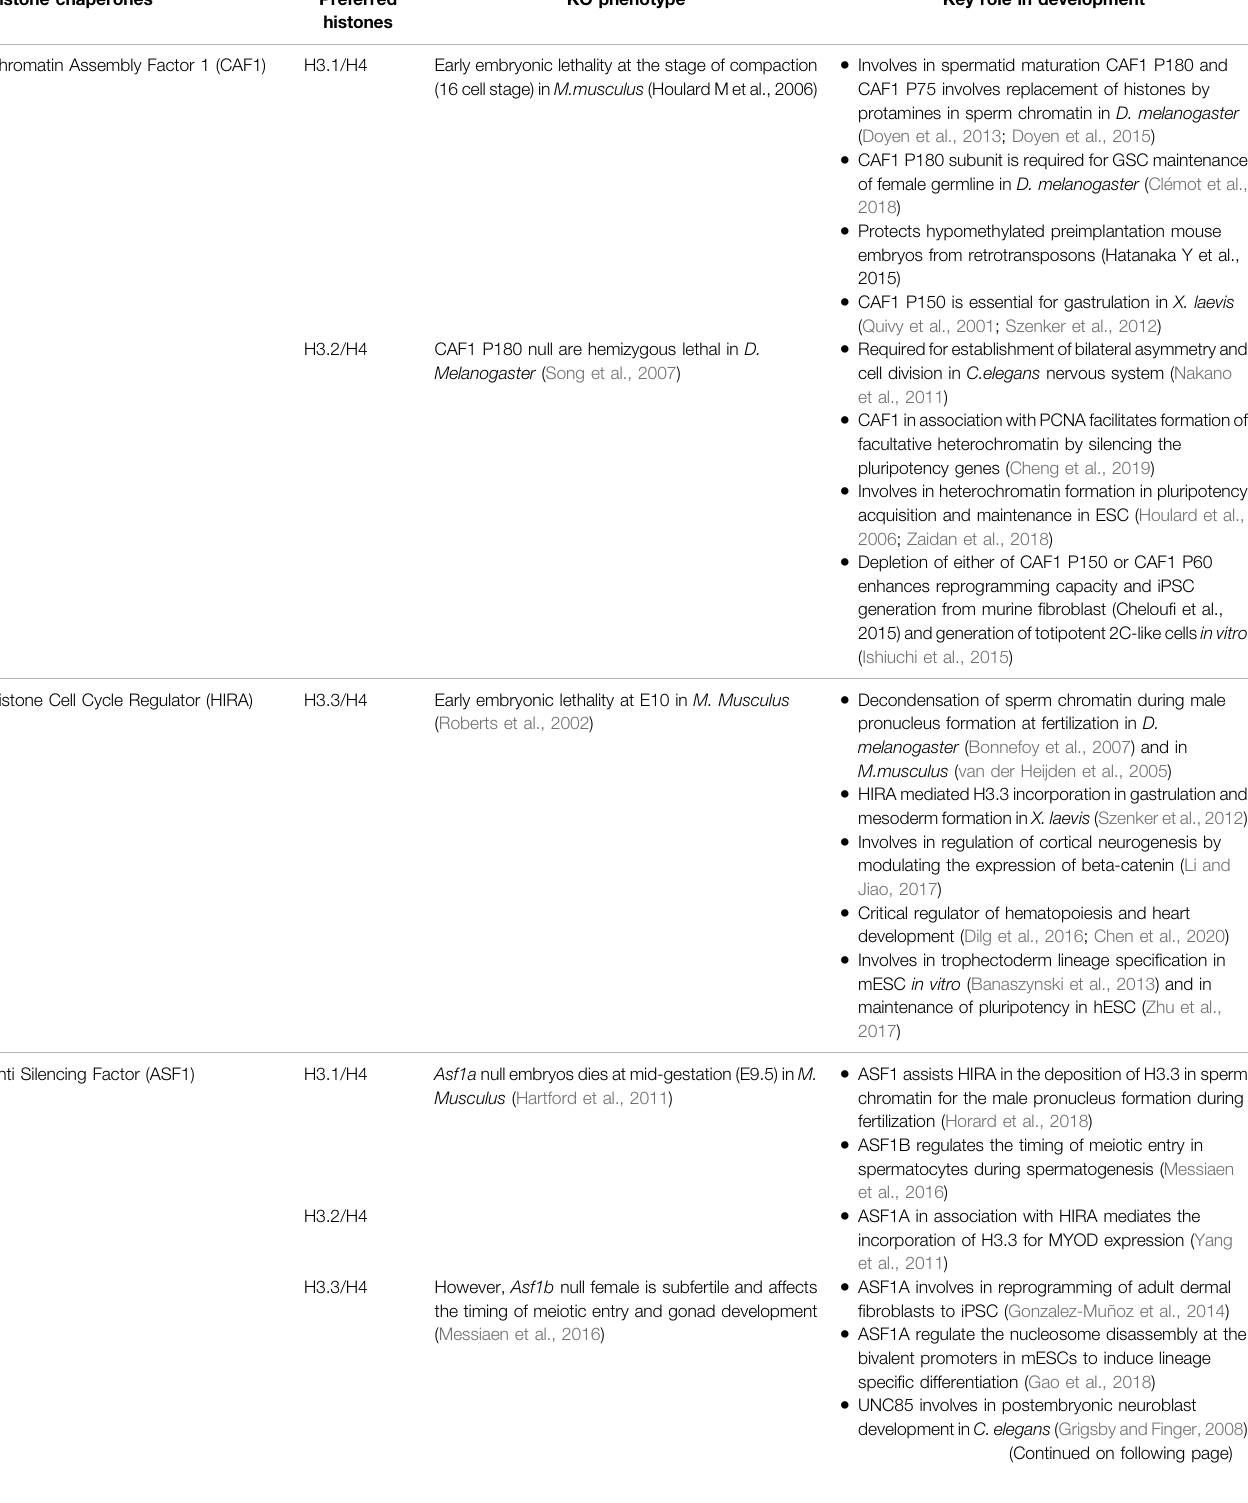
TABLE 1 | Histone chaperones: Types of histones, role in development and KO phenotypes. Histone